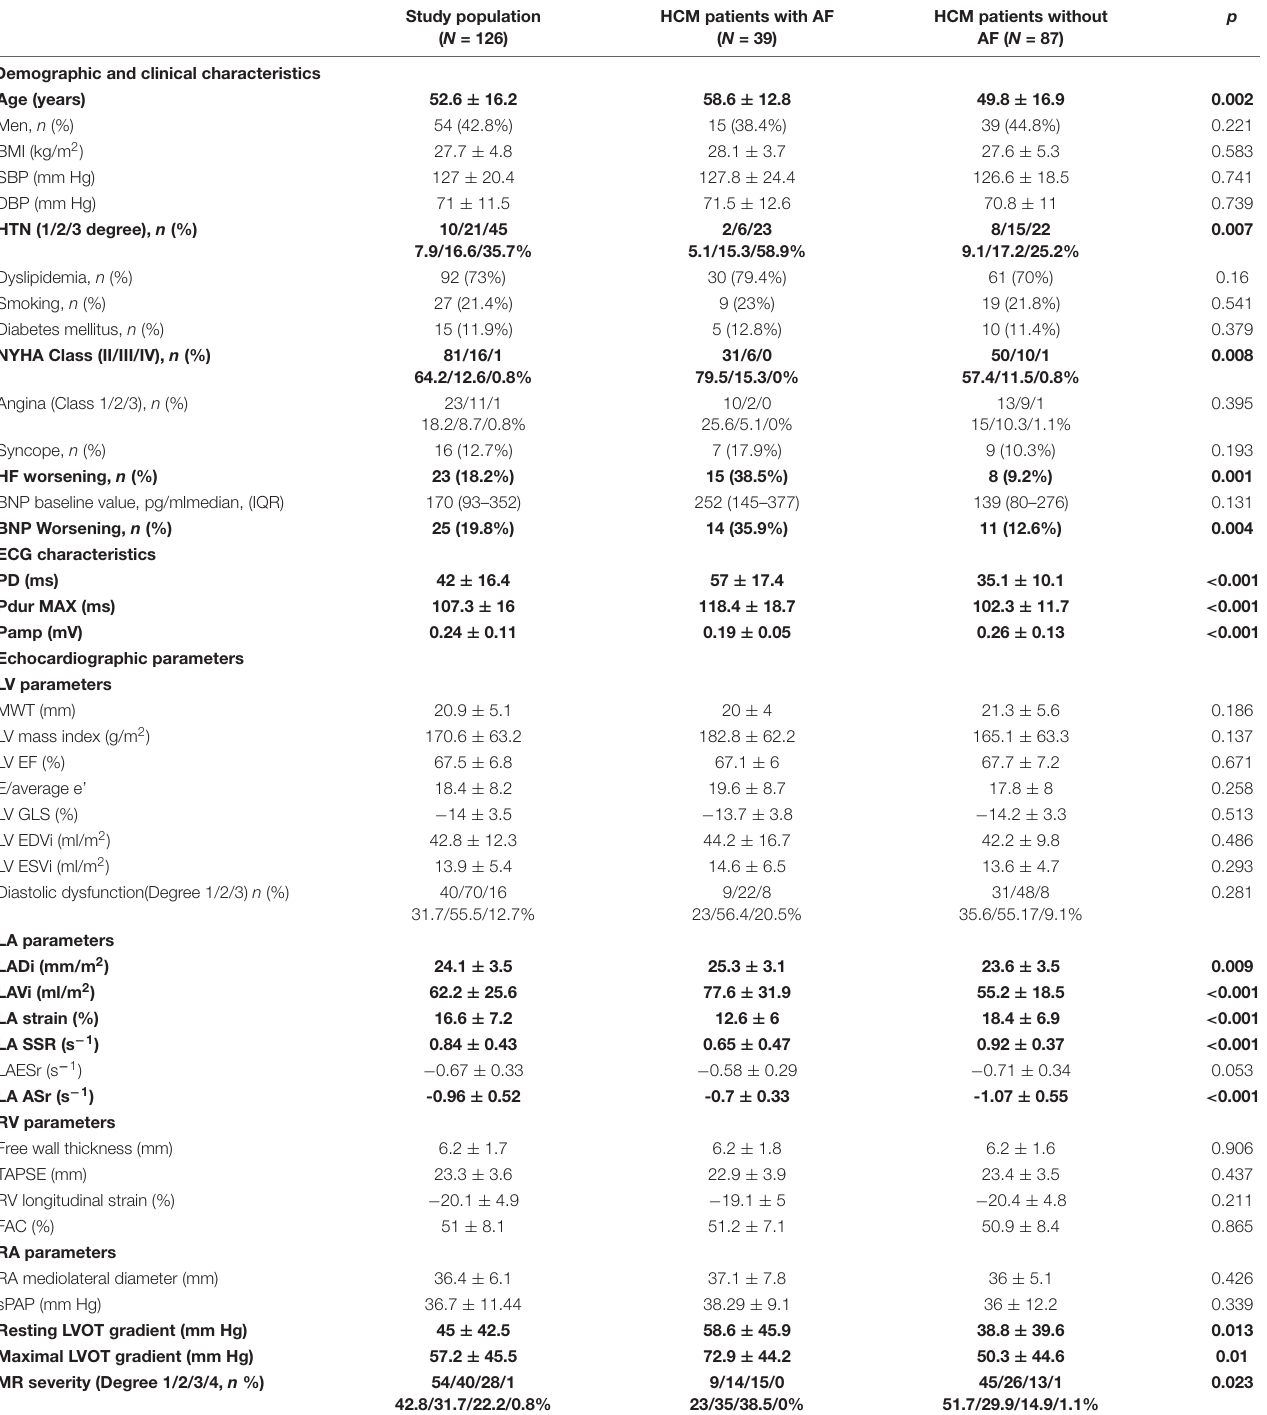
TABLE 1 | Demographic, clinical, ECG, and echocardiographic characteristics in the whole HCM population and in patients with and without atrial fibrillation during follow-up.